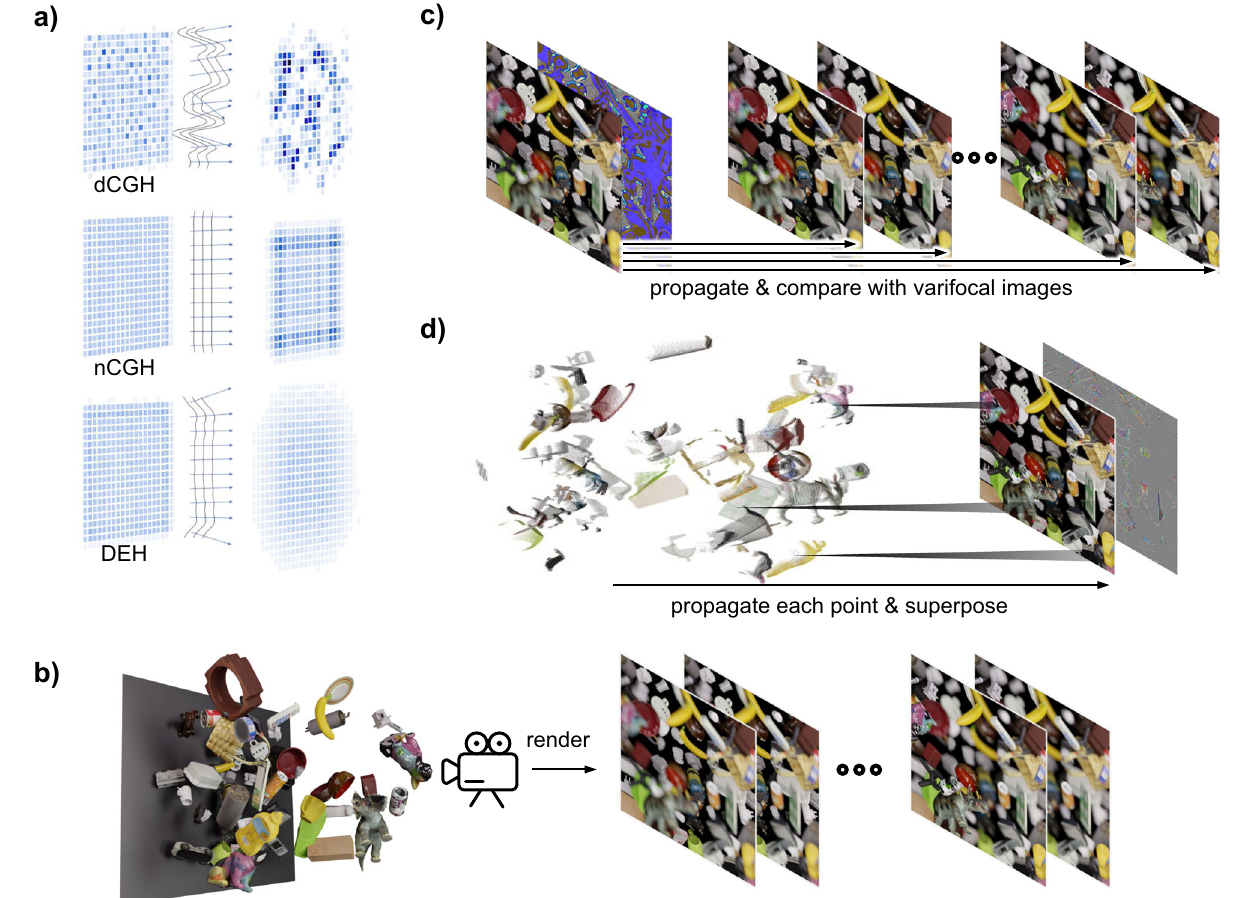
Fig. 1 | Schematics of diffraction-engineered holography. a The intensity dis- tributions of the diffusive hologram (dCGH), the non-diffusive hologram (nCGH), and the DEH are drawn for two different planes when a blue square is recon- structed on the left side. The black lines represent the phases of the various holograms, while the blue arrows represent the propagating direction of the light. In the DEH, the content-dependent phase at the edge of the square spreads light